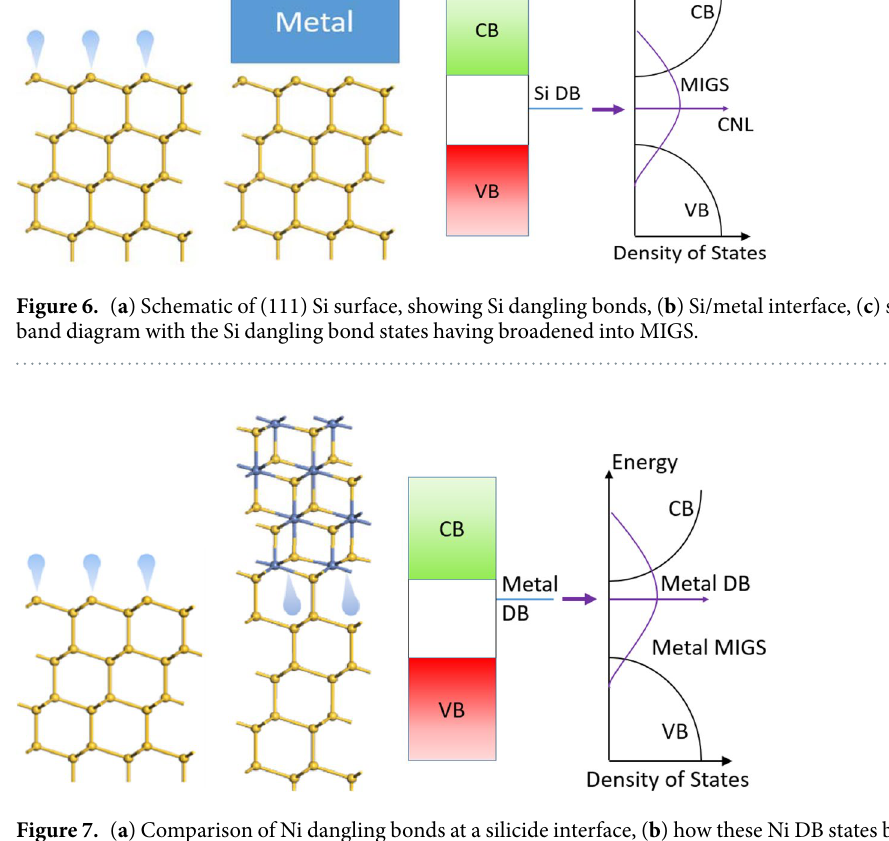
Figure 7. ( a ) Comparison of Ni dangling bonds at a silicide interface, ( b ) how these Ni DB states broaden out to form MIGS at a silicide interface, and ( c ) whose average energy varies as you change the